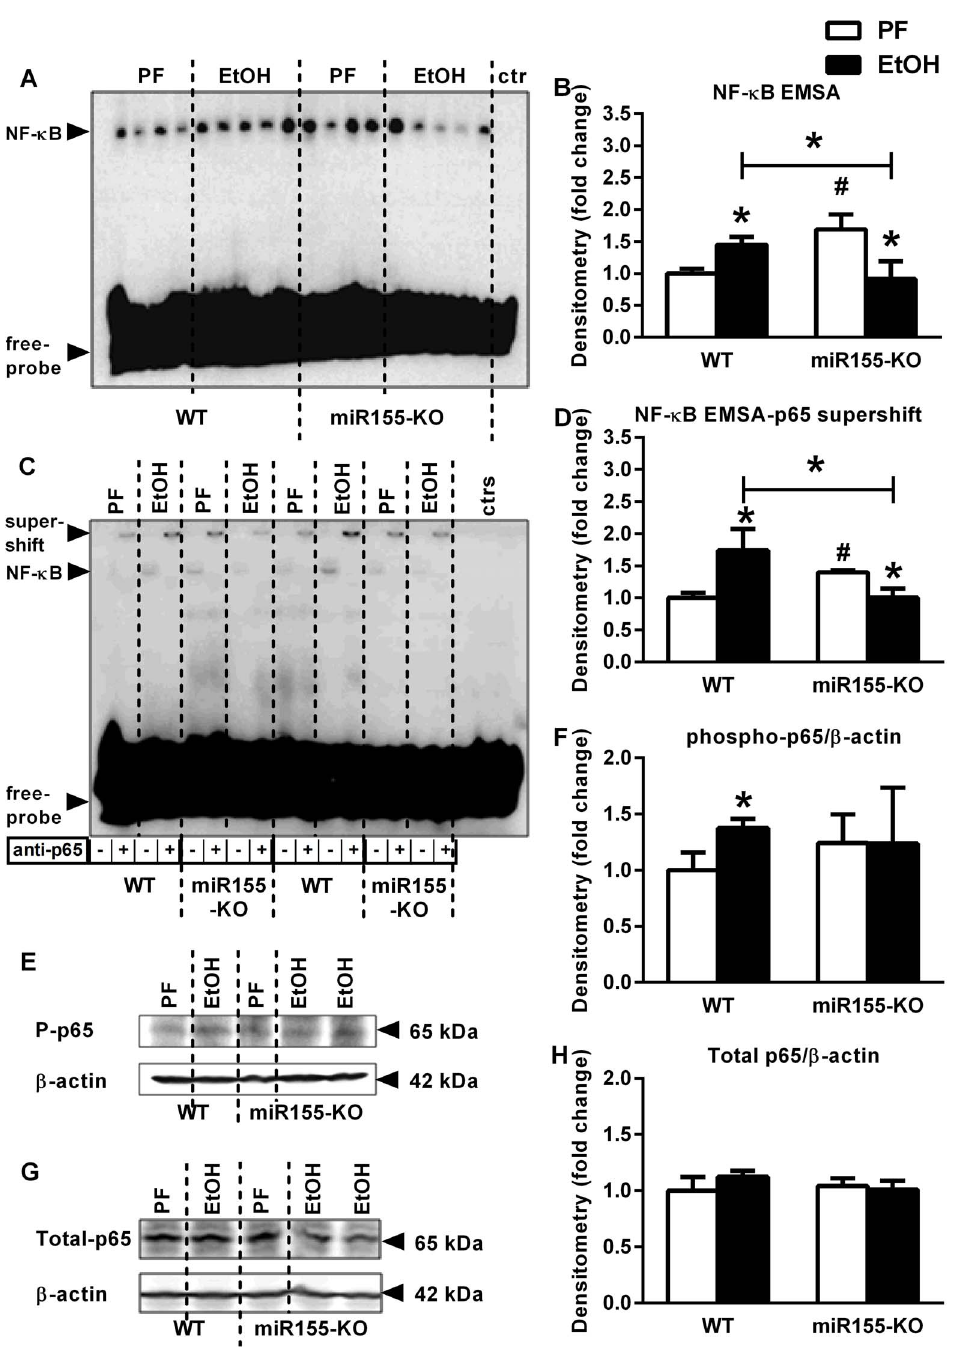
Figure 4. MicroRNA-155 deficiency protects from alcohol-induced NF k B activation in mouse cerebellum. WT (n=6 or 7) or miR-155-KO (n=5 or 10) mice were fed with control (PF) or EtOH diet for 5 weeks, respectively. NF- k B activity of whole cerebellar lysates was assessed by EMSA for NF- k B (A–B) and supershift with anti-p65 antibody (C–D), loading equal amounts of protein, using EtOH-fed cerebellar sample for cold competition control (ctr), and further quantified by densitometry. Phosphorylated-p65 (E–F) and total-p65 (G–H) protein of whole cerebellar lysates was assessed by Western blot, using b -actin as loading control, and further quantified by densitometry which represents six to ten samples per group. Bars represent mean 6 SEM (*, # : p value , 0.05 relative to appropriate PF or WT controls, respectively, by Kruskal-Wallis non-parametric test). doi:10.1371/journal.pone.0070945.g004 protection from caspase-1 activation IL-1 b protein increases [18]. Unlike TNF a and MCP1, IL-1 b increase and caspase-1 activation were not prevented by miR-155 deficiency, which is consistent